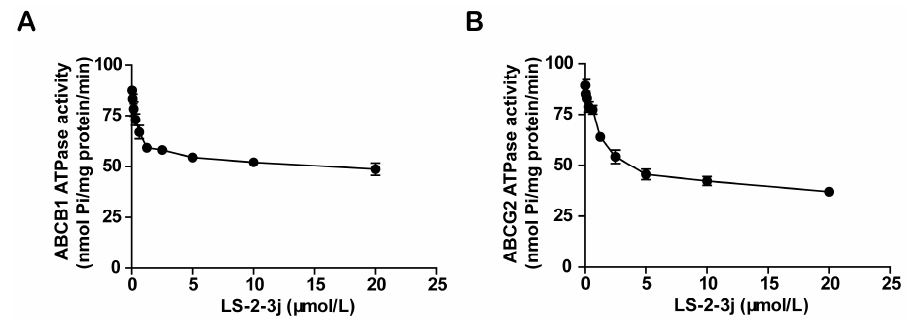
Figure 4. Effect of LS-2-3j on orthovanadate (Vi)-sensitive ABCB1 ( A ) and ABCG2 ( B ) ATPase activity with increased LS-2-3j concentration (0–20 µ mol/L). Each bar represents the mean ± SD of three independent experiments.